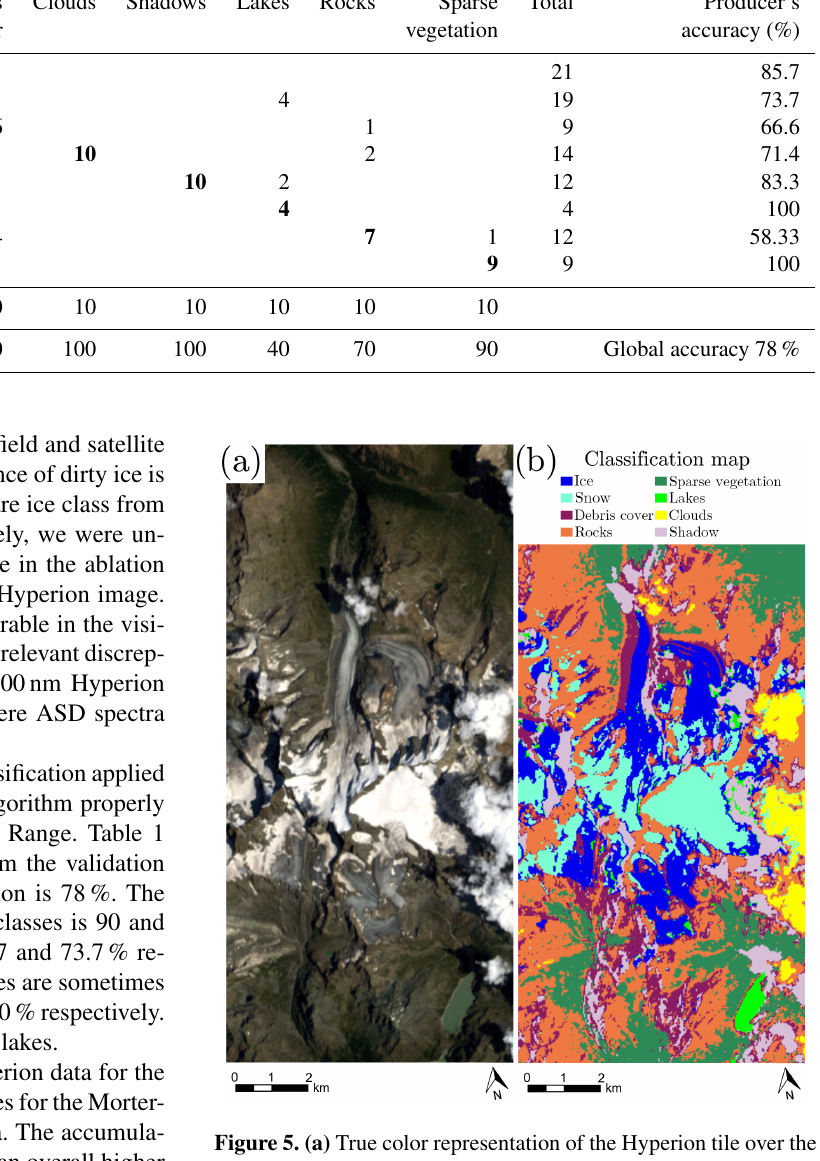
parison between the atmospherically corrected reflectance from Hyperion and Landsat 8 OLI (mean and standard devi- ation) (RMSE = 0.015). The areas selected are the same for Fig. 6a for the Morteratsch Glacier. Despite some noise in the Hyperion spectra, data from the two satellites are in good agreement, both for the three OLI bands (B2, B3, B4) in the visible domain and for the OLI band (B5) in the infrared do-